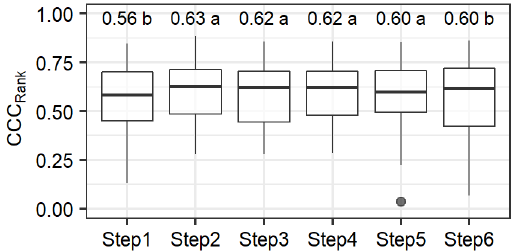
Figure 5. The concordance correlation coefficients of ranks for the stepwise analysis. Values show the median CCC Rank for each treatment. For better visualisation, the figure excluded negative CCC Rank . Steps with the same letters are not significantly different.